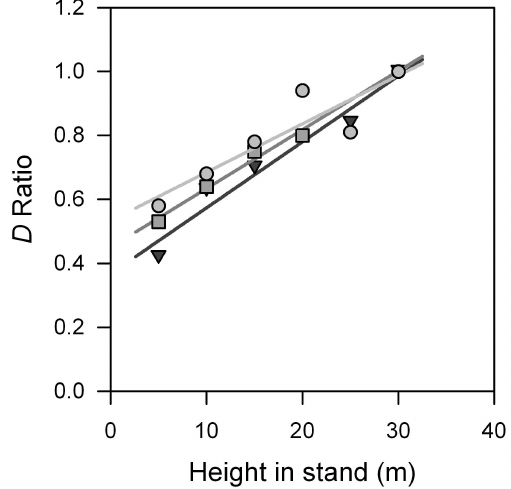
Fig. 1. Increase in mean vapor pressure deficit ( D , relative units, 30m = 1.0) with height in the forest. Regression lines and symbols correspond to three different vertical profiles. Points are mean val- ues for continuous measurements over a period of 12 days in June